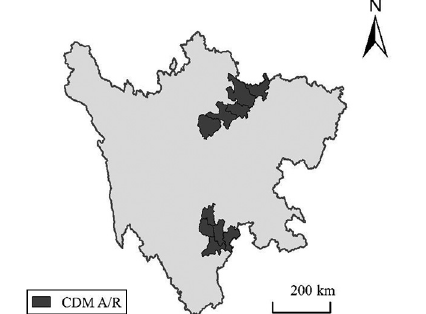
Figure 2. Spatial distribution